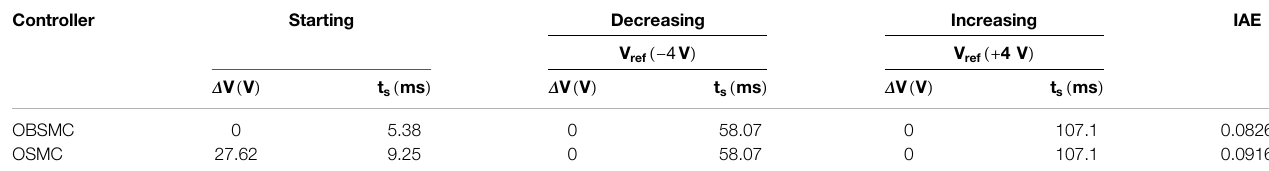
TABLE 2 | Performance speci fi cation of the converter related to reference voltage variations Controller Starting